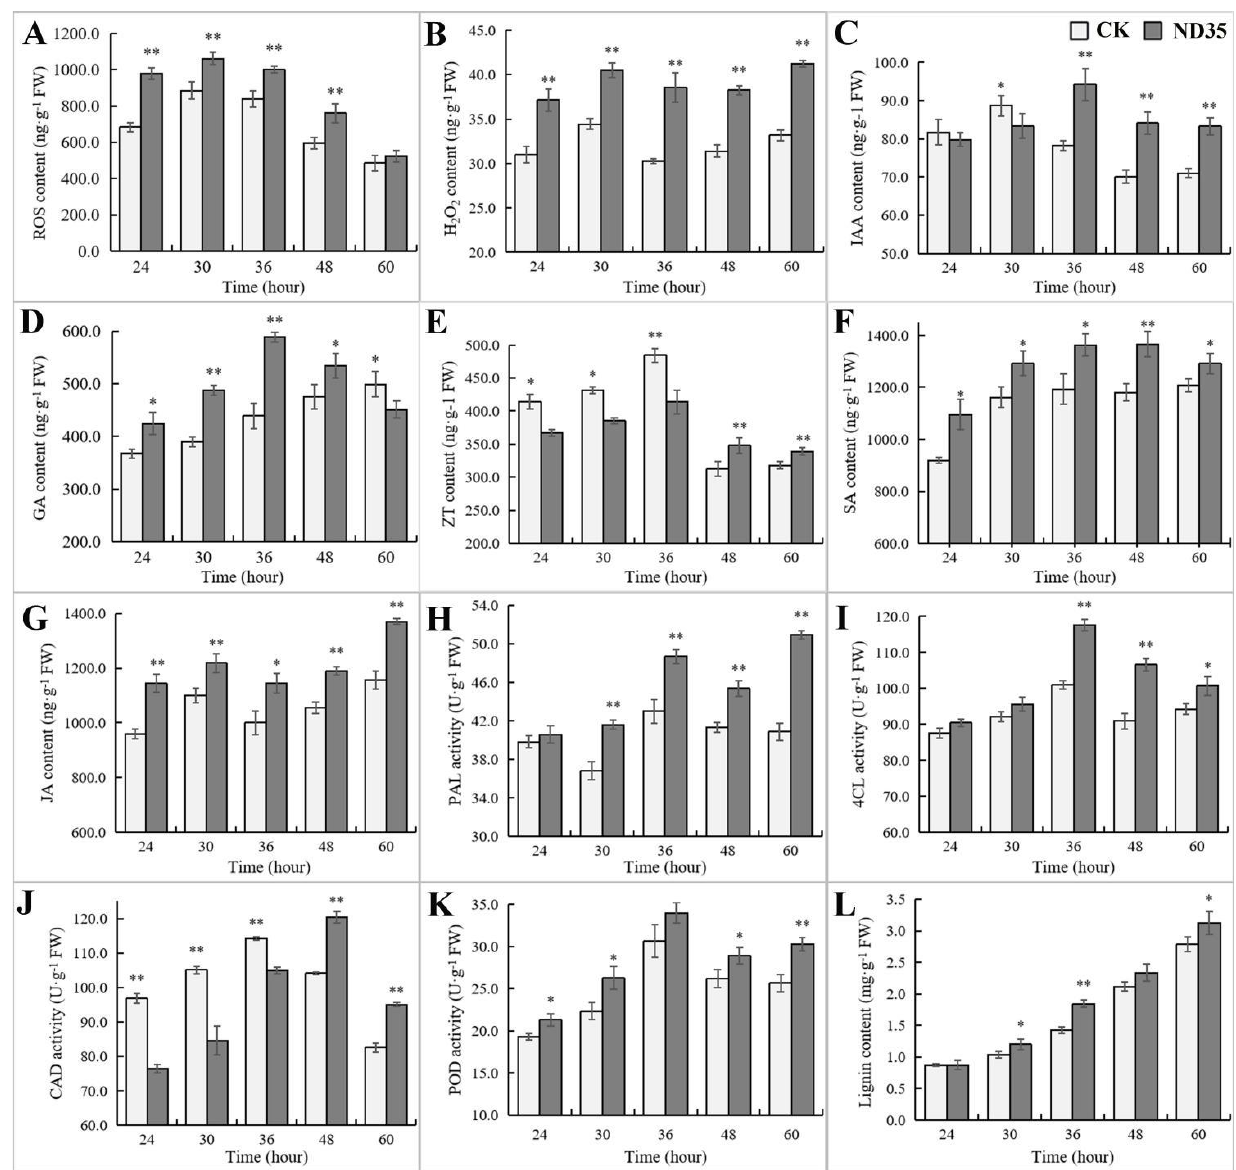
Figure 6. The changes of the biologically active substance of cucumber in responding to the infection and colonization of C. globosum strain ND35 in cucumber radicle. ( A ): The content of reactive oxygen species (ROS); ( B ): The content of hydrogen peroxide (H 2 O 2 ); ( C ): The content of indole-3-acetic acid (IAA); ( D ): The content of gibberellic acid (GA); ( E ): The content of zeatin (ZT); ( F ): The content of salicylic acid (SA); ( G ): The content of jasmonic acid (JA); ( H ): The activity of phenylalanine ammonia lyase (PAL); ( I ): The activity of 4-coumarate-CoA ligase (4CL); ( J ): The activity of cinnamyl alcohol dehydrogenase (CAD); ( K ): The activity of peroxidase (POD); ( L ): The content of lignin. * indicated that there are statistically significant differences between groups based on Student ’ s t-test ( p < 0.05). ** indicated that there are statistically significant differences between groups based on Student ’ s t-test ( p < 0.01).